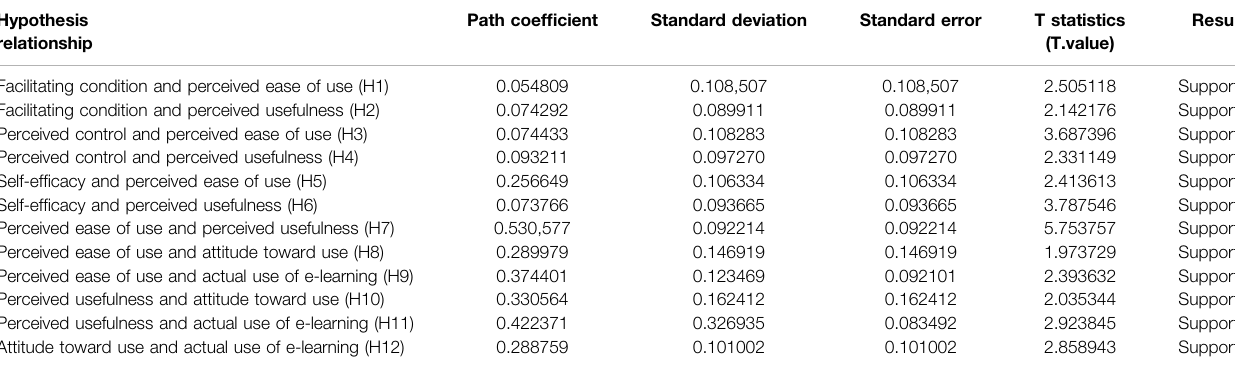
TABLE 4 | Hypotheses